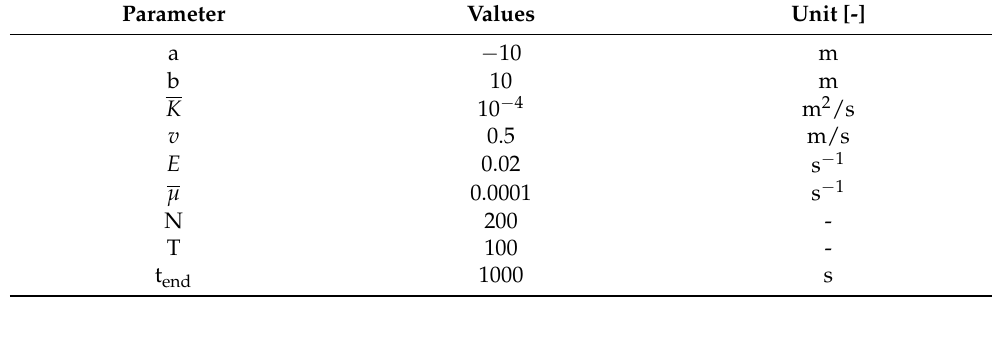
Table 1. Material parameters for FADR analysis.